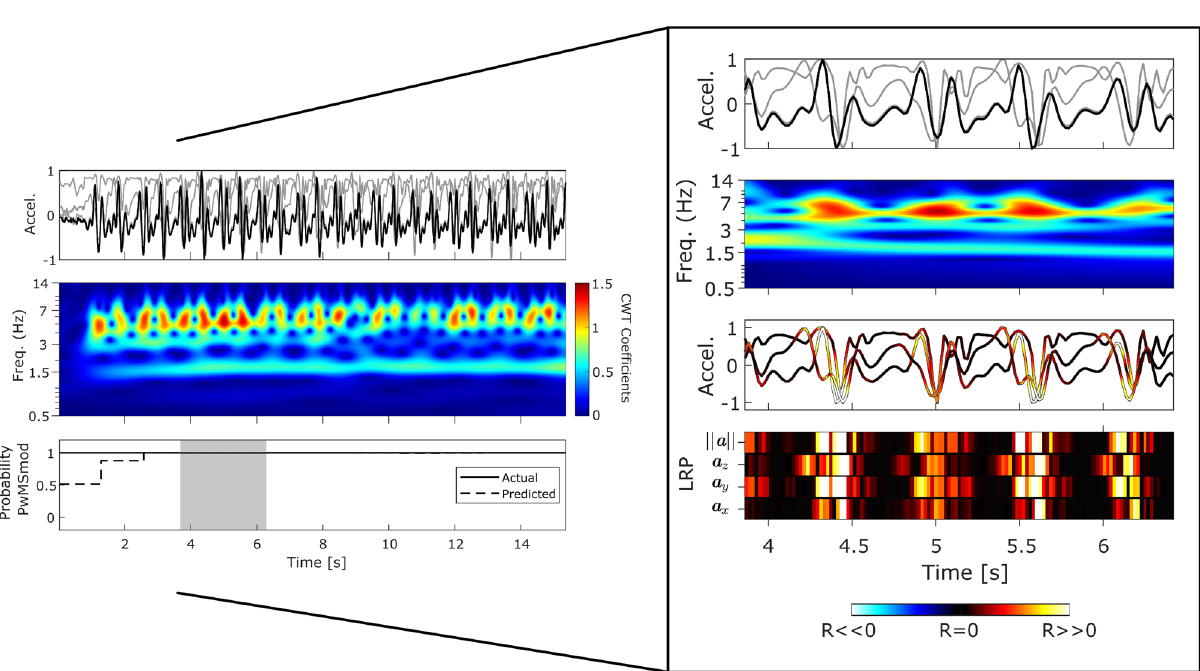
Figure 4. PwMSmod epoch: Panel plot illustrating example performance from a section of a correctly classified PwMSmod subject’s 2MWT (true positive) which can be visually interpreted using LRP decomposition